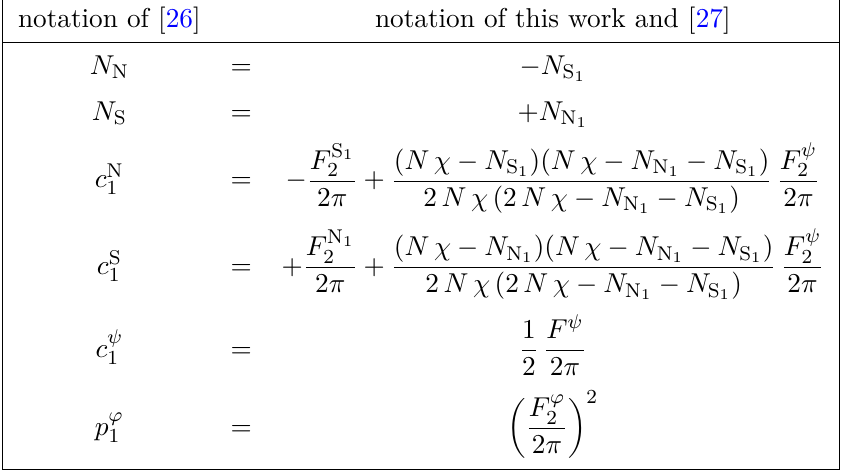
Table 3. Flux parameter and external gauge field strength redefinitions required to match with the results of